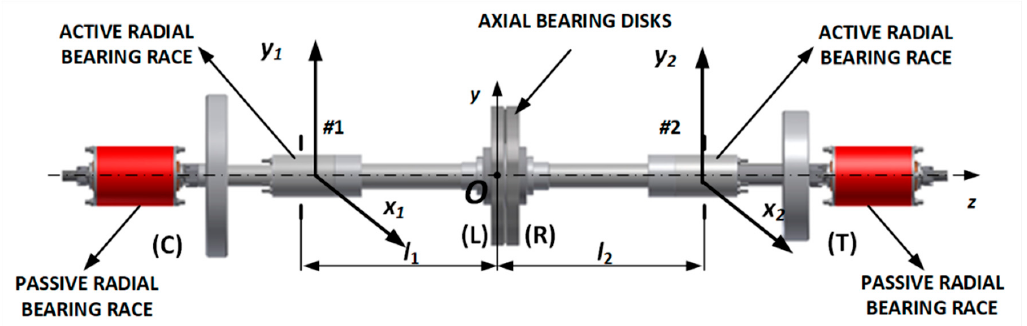
Figure 1. Magnetic suspension system of an unmanned aerial vehicle (UAV) rotor.